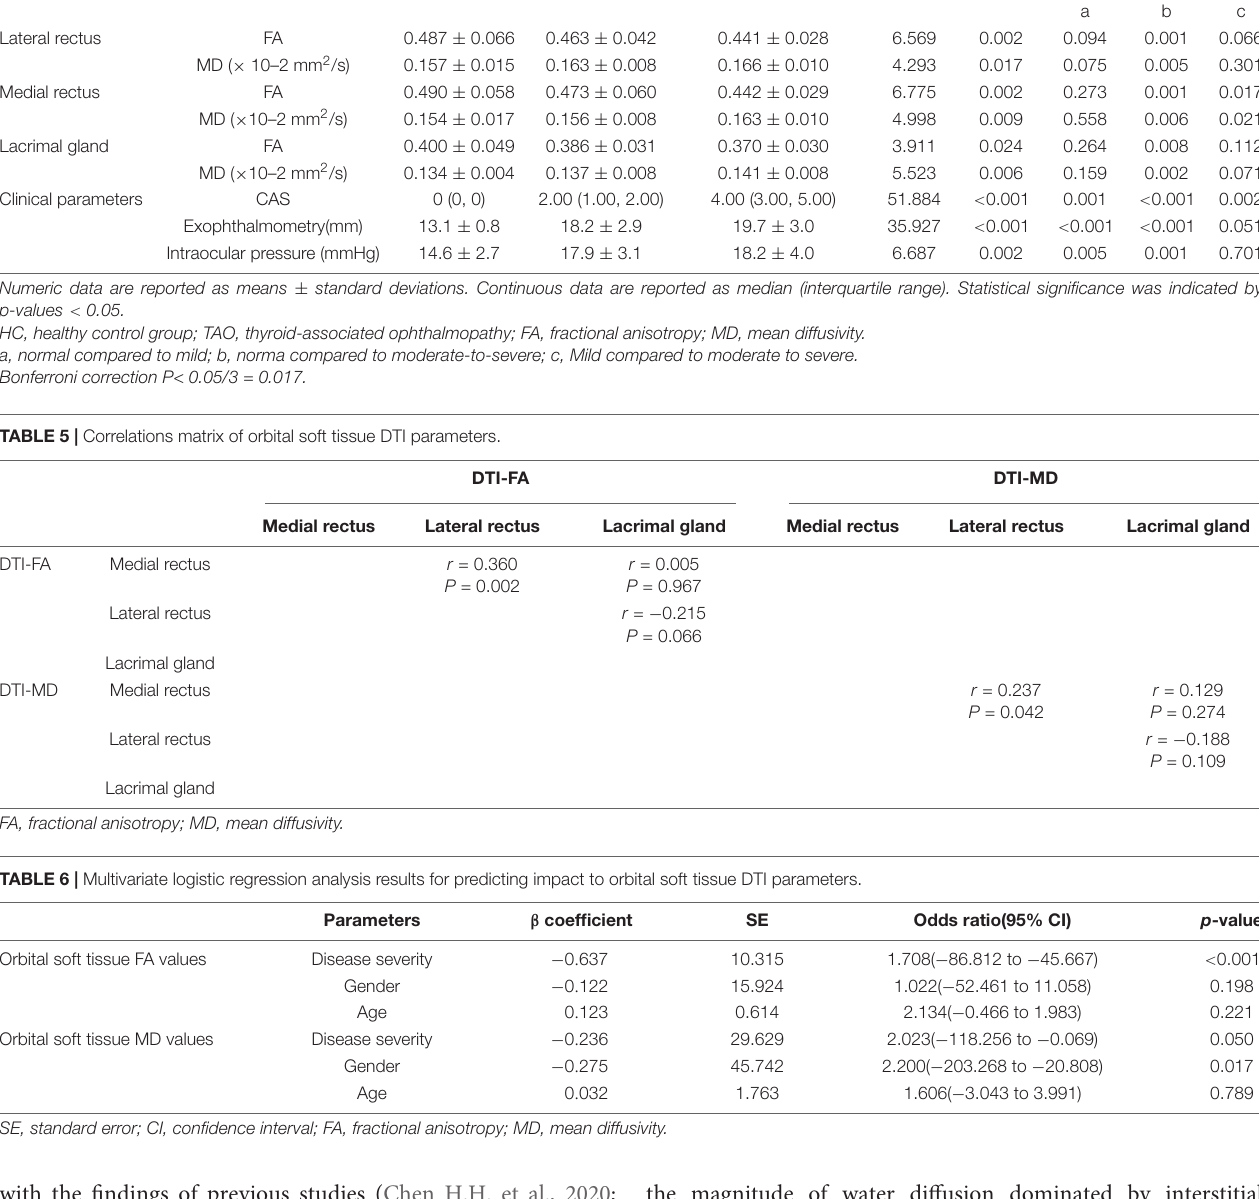
TABLE 4 | DTI parameters of orbital soft tissue and clinical parameters in the normal, mild and moderate-to-severe TAO groups. Parameters